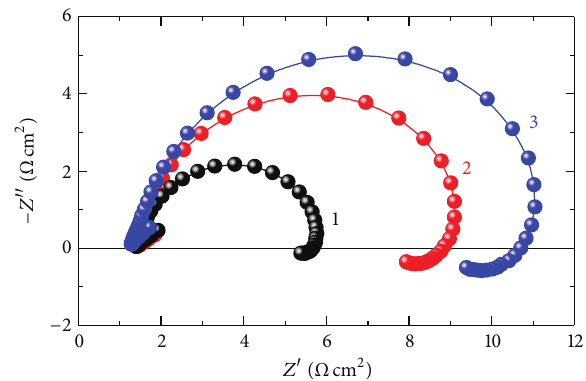
Figure 6: Nyquist plots for the HSLA steel after its immersion for 60 min in 2.0 M H 2 SO 4 solutions in (1) the absence and the presence of (2) 1mM ATA and (3) 5mM ATA,